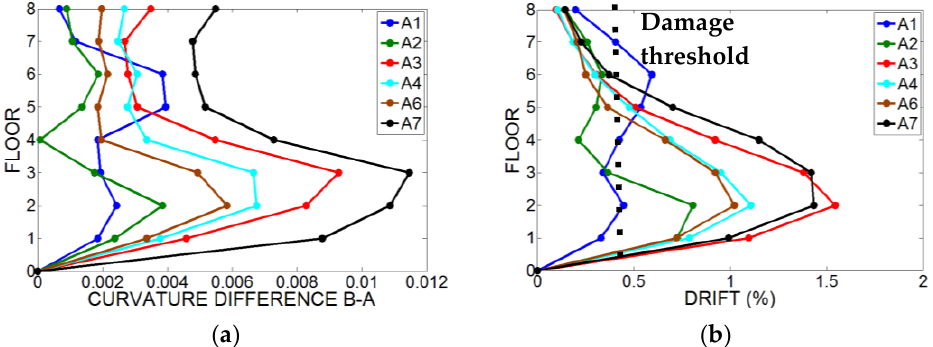
Figure 12. Structural damage localization for the numerical models. Results of the 8-story regular in plan structure: ( a ) curvature difference between the selected time-instants B and A; ( b ) inter-story drift and damage threshold equal to 0.5% (for non-structural components) valid for reinforced con- crete framed structures.